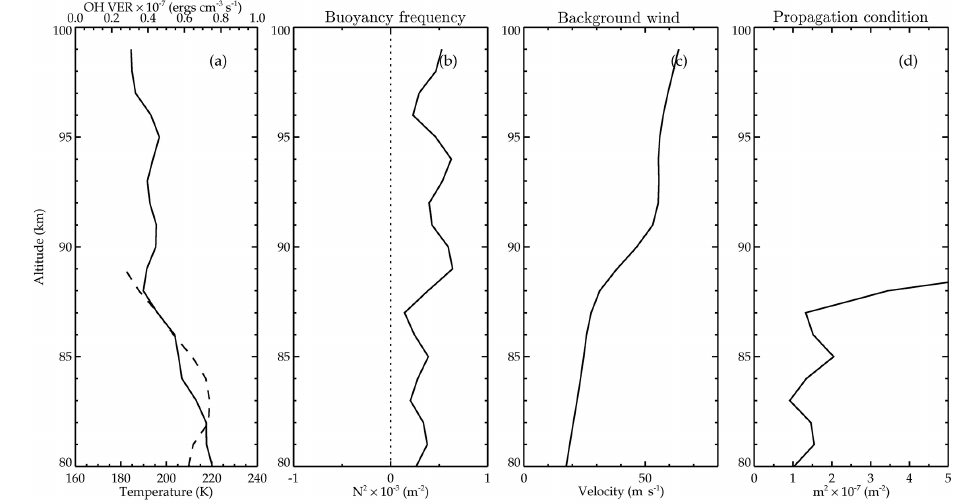
Figure 8. Same as Fig. 5 but for the mesospheric front observed on 29 August